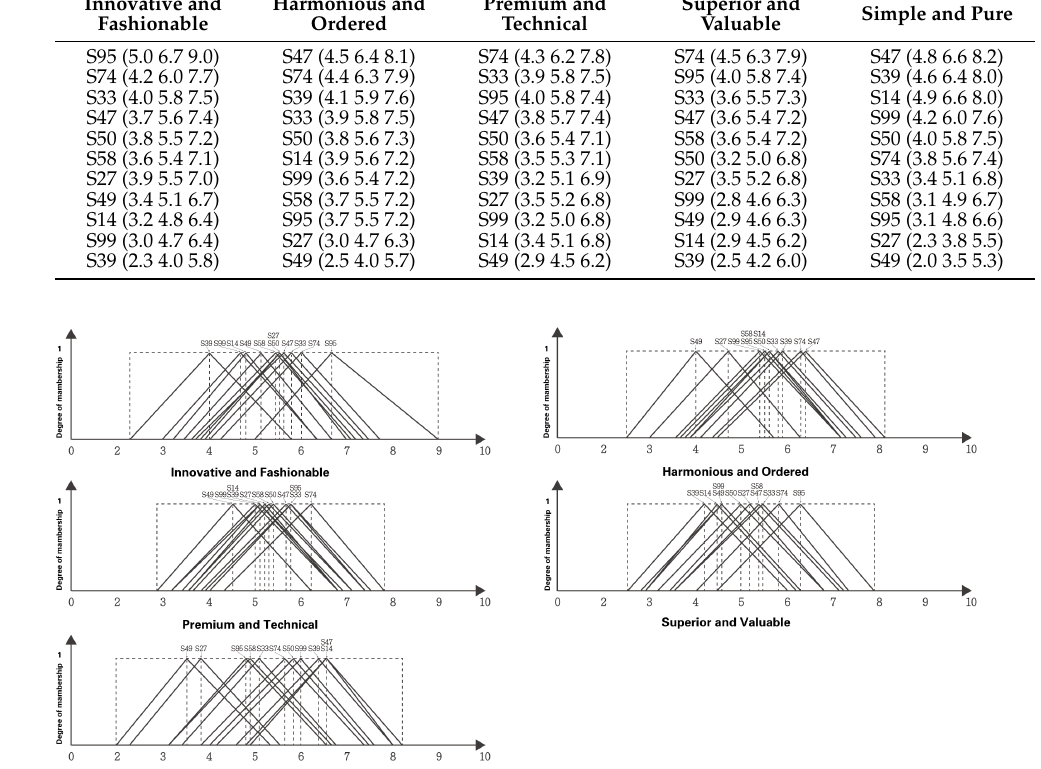
Figure 7. The triangular fuzzy numbers of the 11 representative samples in each visual